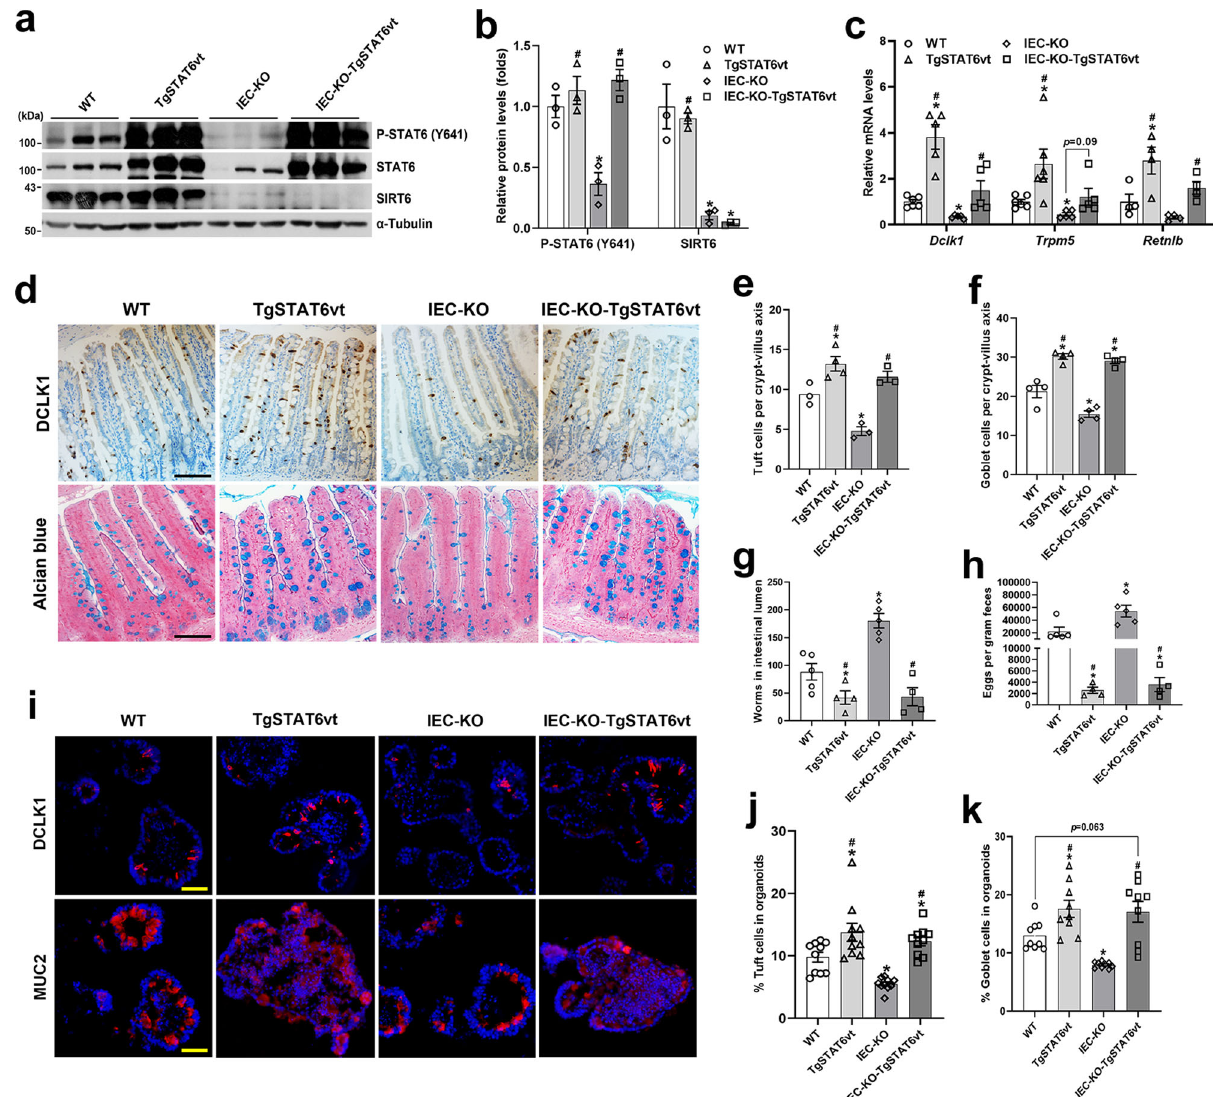
Fig. 6 | IEC STAT6vt overexpression rescues the defective intestinal type 2 immunity resulting from Sirt6 deletion. 2 – 3-month-old male mice with 4 geno- types (WT, TgSTAT6vt, IEC-KO, IEC-KO-TgSTAT6vt) wereinfected with H.poly and subjected to the following analyses on day 14 post-infection. a , b Western blot ( a ) and quanti fi cation ( b ) analyses of P-STAT6 (Y641) and SIRT6 in the jejunal IECs. n =3 mice/group; from left to right, P-STAT6 (* p =0.0083; # p =0.0074, 0.0026); SIRT6 (* p =0.0358, 0.0344; # p =0.0002). c qPCR analysis of the expression of Dclk1 , Trpm5 and Retnlb in the jejunal IECs. Dclk1 , Trpm5 , n =5 mice/group; Retnlb , n =4 mice/group; from left to right, Dclk1 (* p =0.0054, 0.0019; # p =0.0027, 0.0494); Trpm5 (* p =0.0389, 0.0085; # p =0.0184); Retnlb (* p =0.0466; # p =0.0232, 0.0154). d Tuft and goblet cells were examined by DCLK1 immunos- taining and Alcian blue staining, respectively in the jejunum (200X). e , f Quanti fi cation of tuft ( e ) and goblet ( f ) cells shown in ( d ). n =3, 4, 3, 3 mice/